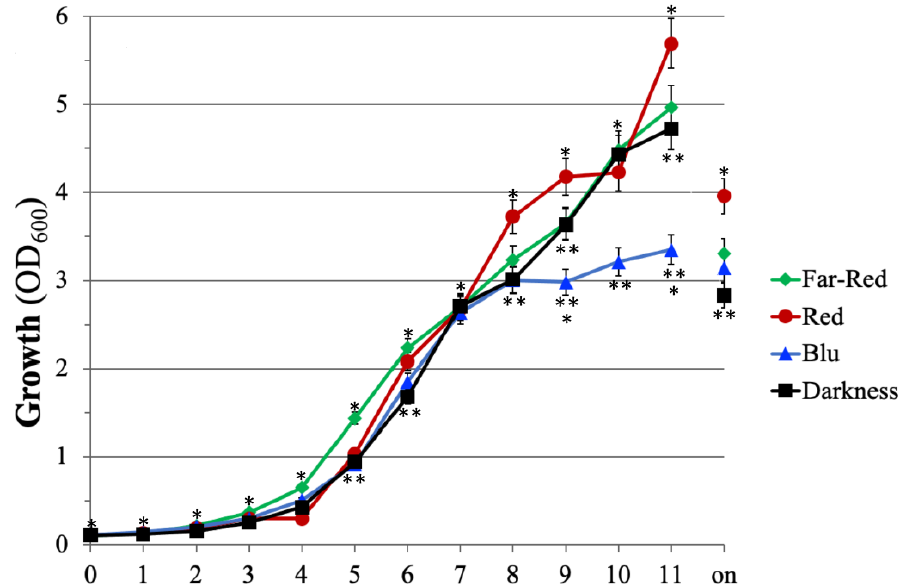
Figure 1. The effect of monochromatic light on the growth of E. amylovora Ea273 in shake flask cultures. The data are representative of three independent experiments with three biological and two technical replicates. Error bars represent the SD. The number of asterisks adjacent to the symbols, at the same time point, indicates significant differences between different growth conditions (Student’s t -test, p ≤ 0.05).